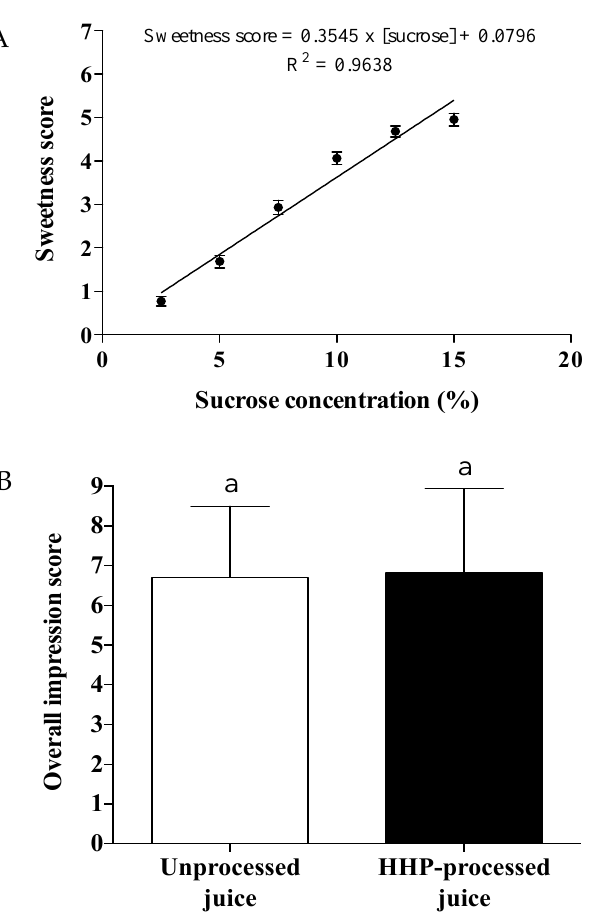
Figure 4. ( A ) The ideal concentration of added sucrose in jussara juice (12.5%) was determined from the linear regression analysis of the sweetness score (mean ± standard error of the mean; n = 99). ( B ) No significant difference was observed between the overall impression score of sweetened unprocessed and HHP-processed (200 MPa for 5 min) jussara juice (Wilcoxon matched-pairs signed- rank test, n =